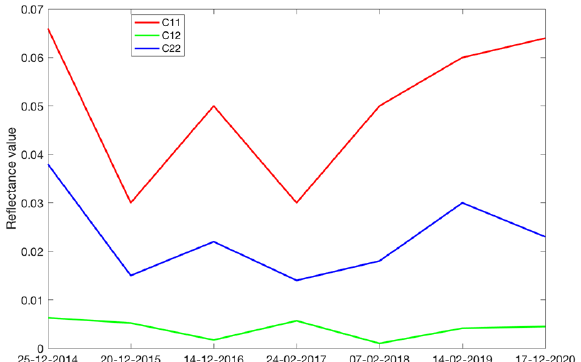
Figure 2: Sentinel 1 SLC covariance matrix generated band av- erages of C11, C12 and C22 response on the degraded Riparian Reserve 2014-2020 of Lake Nakuru,